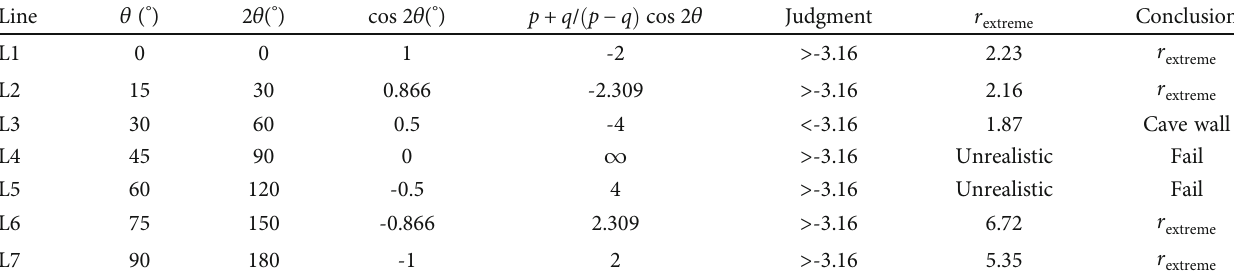
Table 8: The sensitivity of the displacement to the